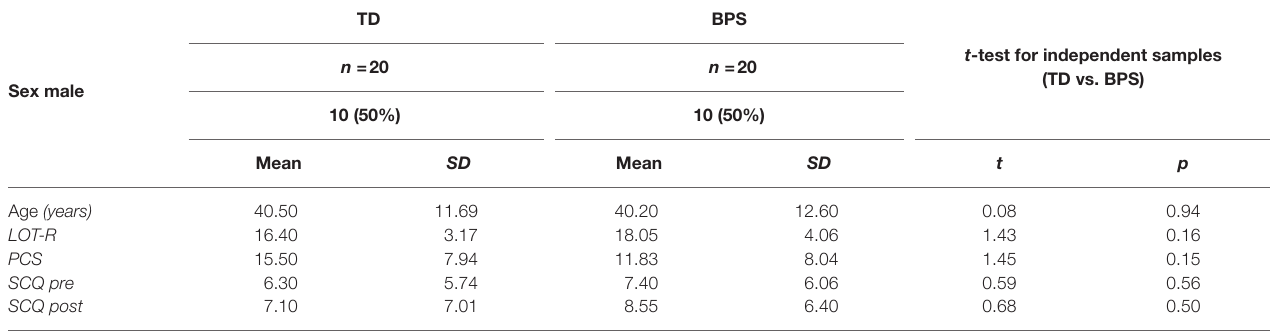
TABLE 1 | Demographics and trait measures of optimism and pain catastrophizing and situational pain catastrophizing. TD